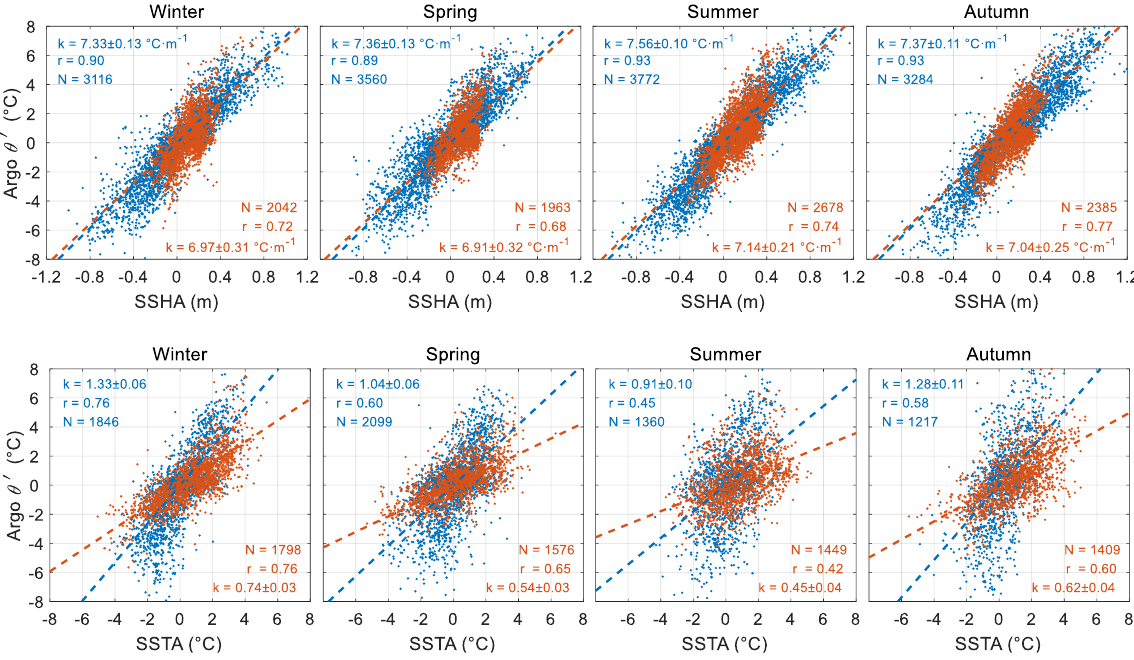
Figure 6. ( Upper ) The seasonal scatterplots of SSHA signals and Argo subsurface temperature anomalies θ (cid:48) in SSHA-based eddies. ( Bottom ) The seasonal scatterplots of SSTA signals and Argo subsurface temperature anomalies θ (cid:48) in SSTA-based eddies. The blue scatterplots are the result for the Kuroshio region (the latitudes of 25 ◦ –38 ◦ N) and the orange scatterplots are the result for the Oyashio region (the latitudes of 38 ◦ –45 ◦ N). The θ (cid:48) is computed as the average temperature anomaly of Argo profile within the eddy at depths of 100–500 dbar. The dashed lines are the linear regression of the scatterplots. The regression coefficient k ( θ (cid:48) /SSHA or θ (cid:48) /SSTA) with the error denoting its 95% confidence interval, the correlation coefficient r , and numbers N of matched results are labeled in the